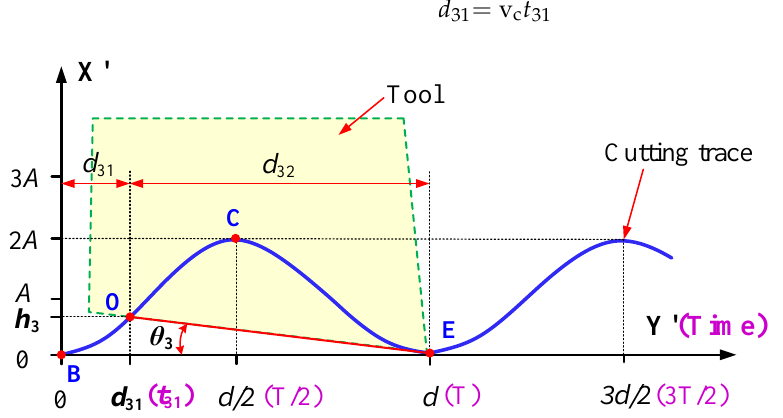
Figure 8. Sinusoidal cutting trace, varying with time, under the state of η 2 > tan α .